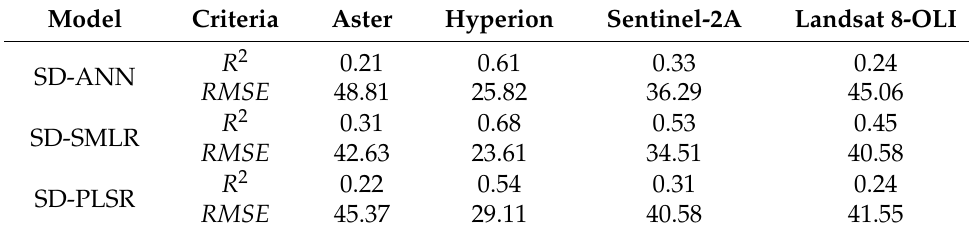
Table 7. Prediction results of Cr concentration using satellite images.